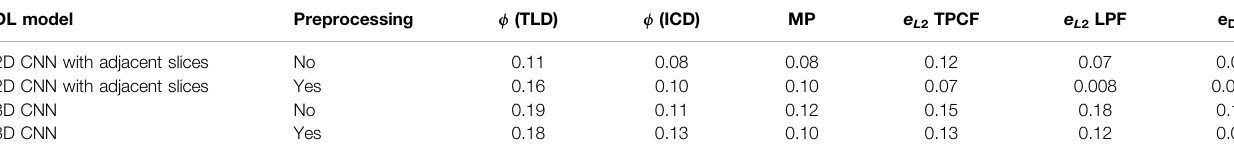
2D CNN with adjacent slices